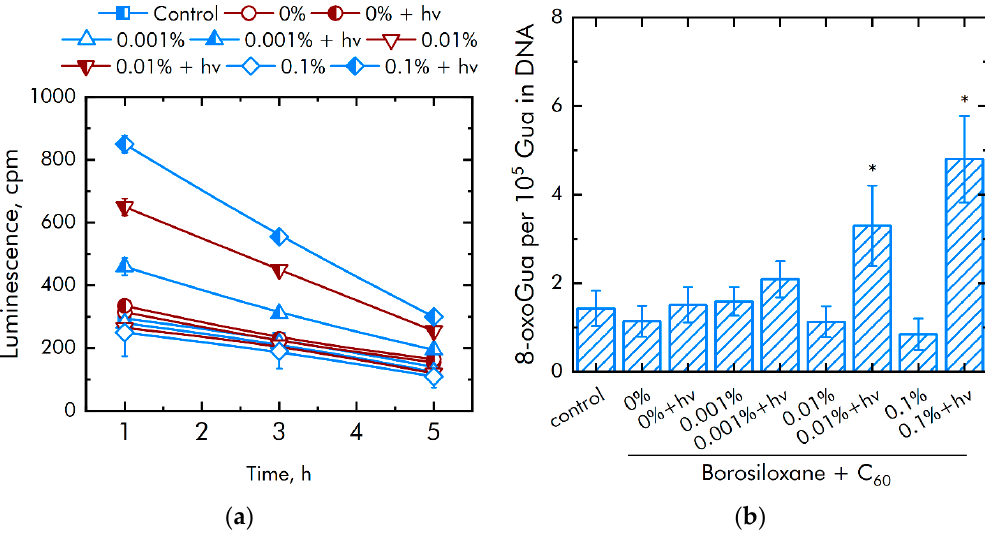
Figure 8. Effect of composite material containing borosiloxane and fullerenes on the generation on biomacromolecules damage: ( a ) Formation of long-lived reactive protein species (2 h, 40 °C); ( b ) Generation of 8-oxoguanosine (2 h, 45 °C); * indicate a significant difference at 5% level in comparison with the control ( p < 0.05). Data are presented as mean values and standard errors.